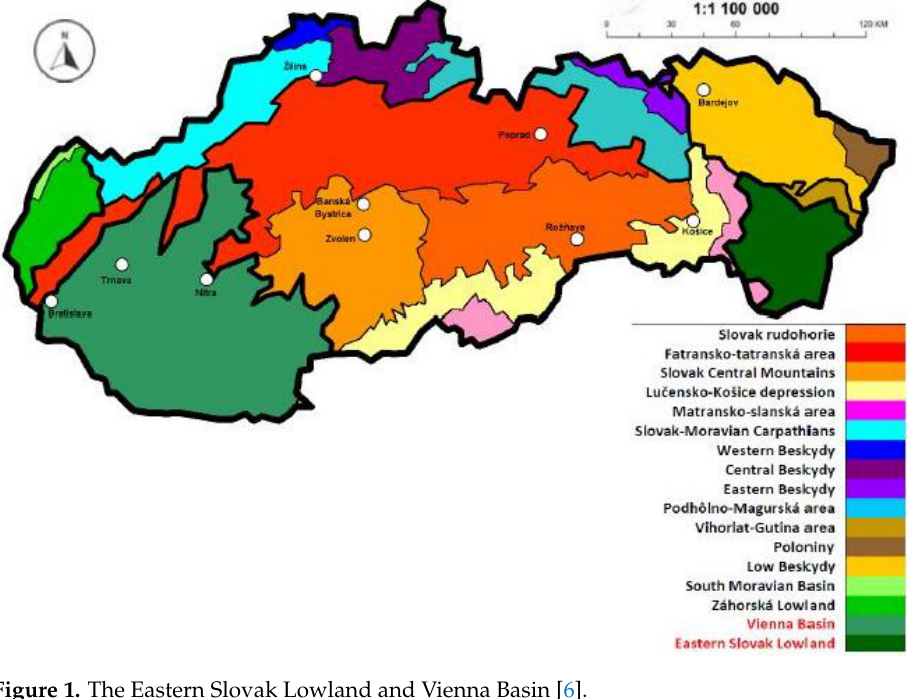
Figure 1. The Eastern Slovak Lowland and Vienna Basin [6].